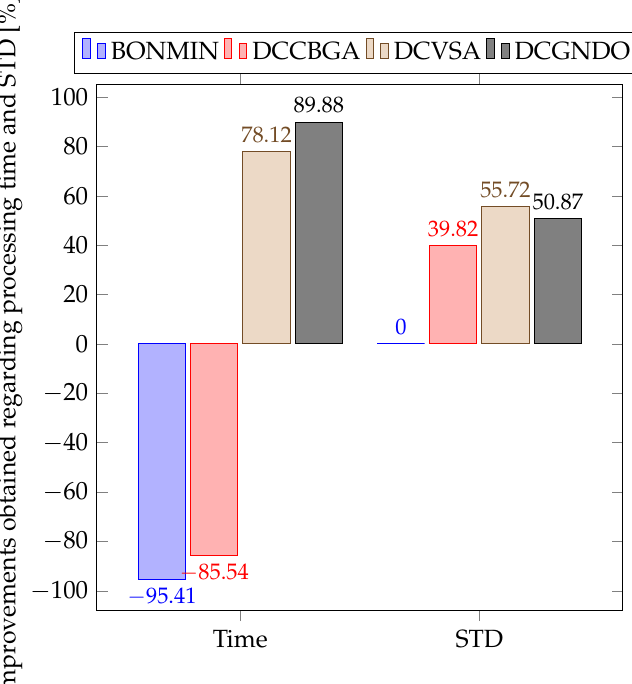
Figure 5. Improvements obtained by the DCPPSO with respect to the comparison methods in the 33-bus test system in terms of processing time and standard